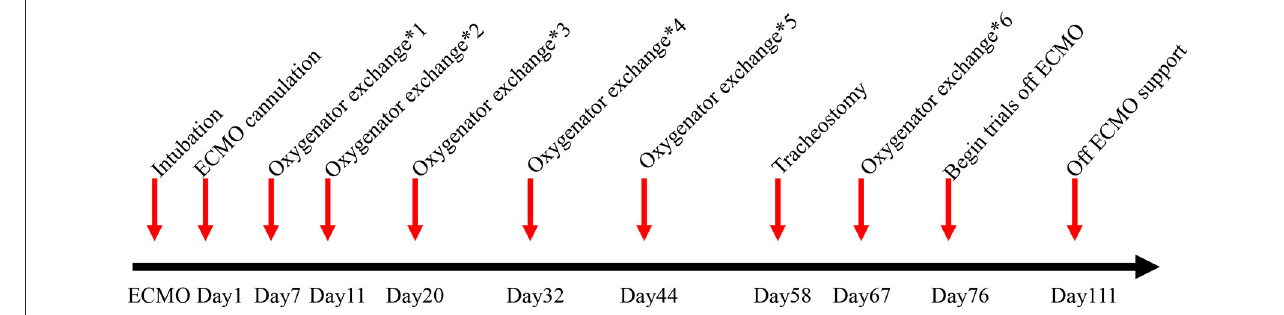
FIGURE 2 | Timeline of ECMO events.